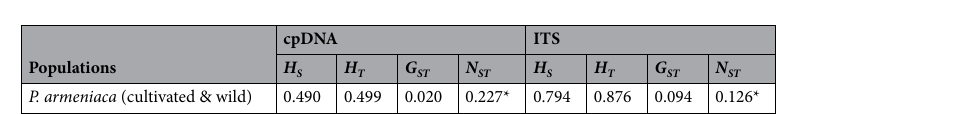
Table 3. Estimates of average gene diversity within populations ( H S ), total gene diversity ( H T ), interpopulation differentiation ( G ST ) and number of substitution types ( N ST ) for cpDNA haplotypes and ITS genotypes of P. armeniaca . Ns, not significant; *, P < 0.05.